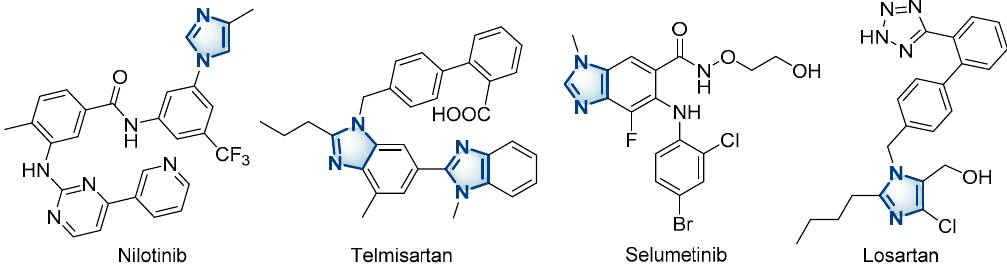
Figure 1. Active pharmaceutical ingredients (APIs) and approved drugs based on the imidazole structural motif.